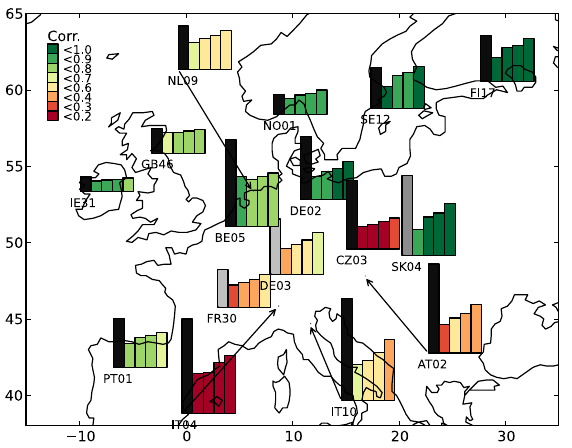
Fig. 8. Observed and modelled TC PM during the winter half-year Fig. 7. Observed and modelled TC PM during the summer half- 10 10 period (November–April) at different European sites from the CAR- year period (May–October) at different European sites from the CARBOSOL (2002–2004) and EMEP EC/OC (2002–2003) cam- Details/Notation see Fig. paigns. The leftmost bars show observed average concentrations (black for stations located at less than 600m altitude, light gray for sites above 1000m and medium gray for stations at 600–1000m height) and the following four bars the corresponding model con- centrations with the four different model versions (NPNA, PAP, PAPA and PAA). The colours of the model bars illustrate the corre- lation coefficients, see legend. Some stations are moved for clarity, location indicated with arrows. Note that number of samples varies between stations ( N = 13 for CZ03, N ≥ 22 for other sites) – see Table S1 for details and results from other campaigns.